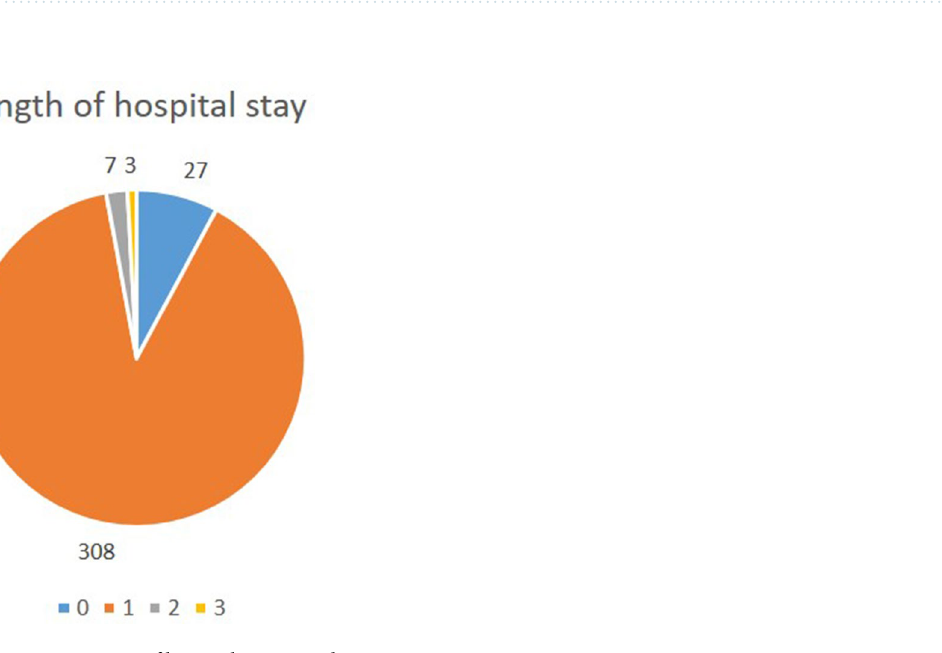
Table 2. Comparison of characteristics of both intracapsular and extracapsular groups. SD standard deviation, ATH adenotonsillar hypertrophy, RT recurrent tonsillitis, TTS total symptom score.